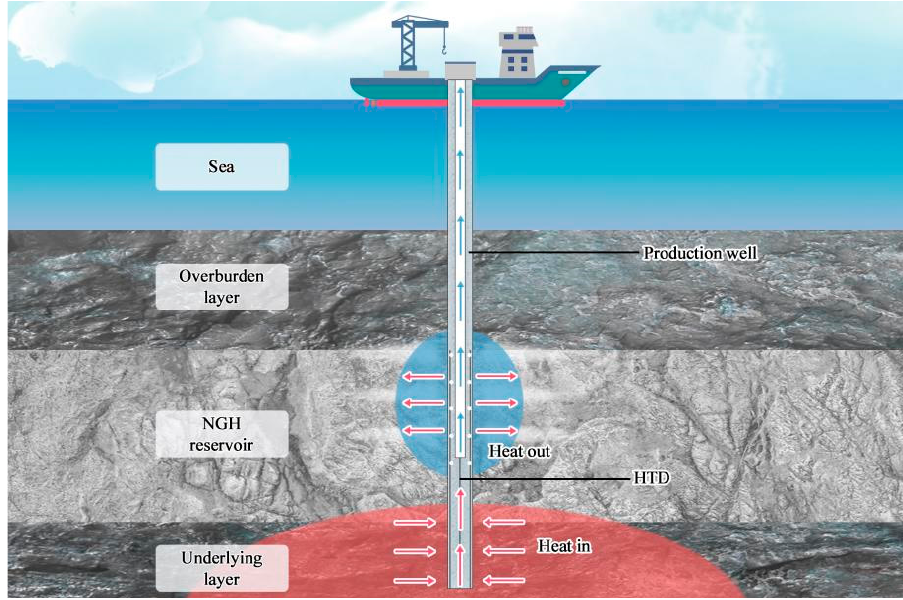
Figure 3. Schematic of the HTD working in depressurization production.